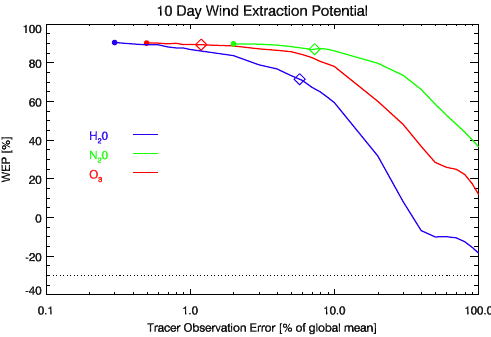
Fig. 10. WEP (in %) as a function of specified tracer observation error for O 3 (red), N 2 O (green), and H 2 O (blue). BEST experiment values are indicated with circles, and MLS experiment values (i.e., using MLS precision levels) are indicated with diamonds. The black dotted line indicates the result for no data